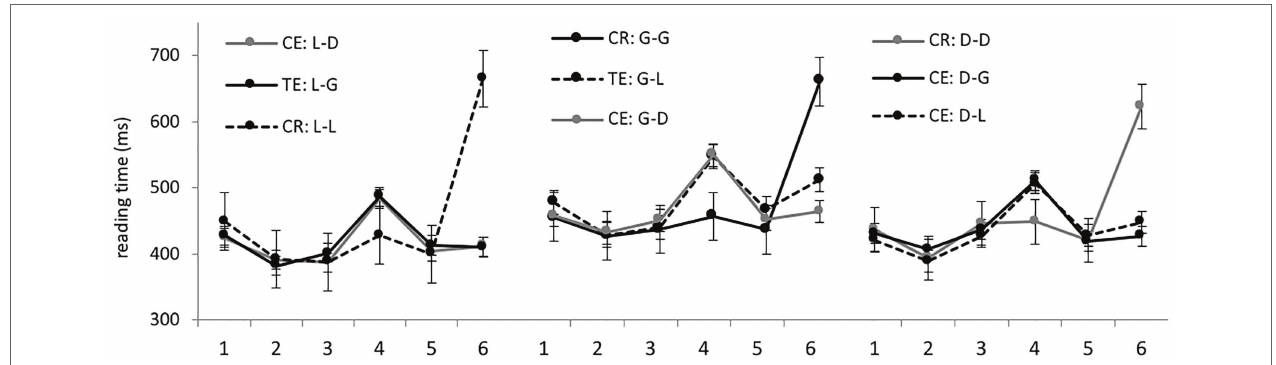
FIGURE 1 | Native speaker group: average RTs per region (in ms) in the nine experimental